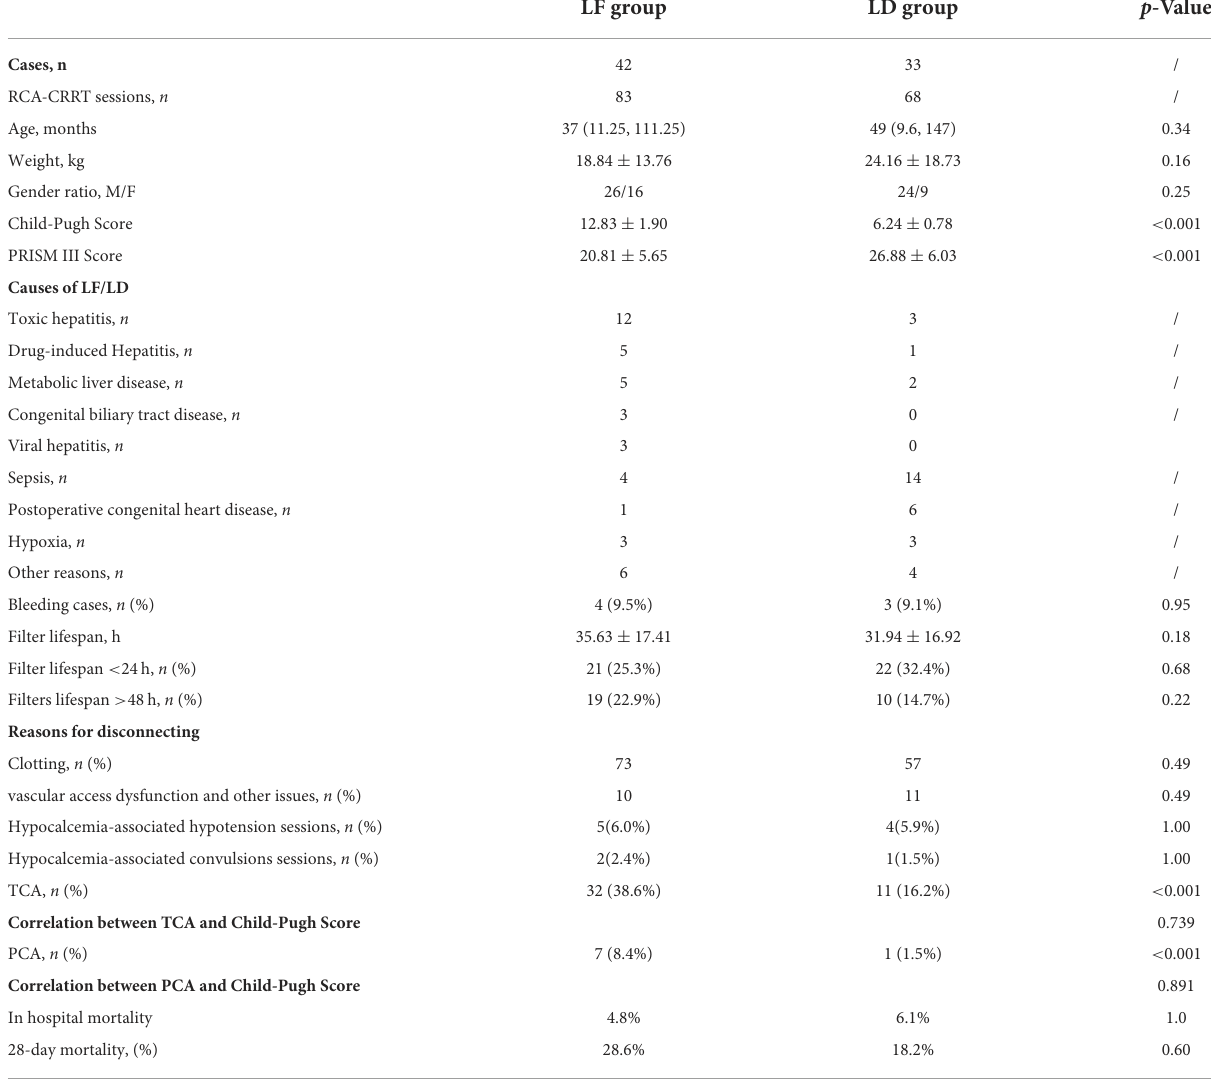
TABLE 1 General data of children in the LF group and LD